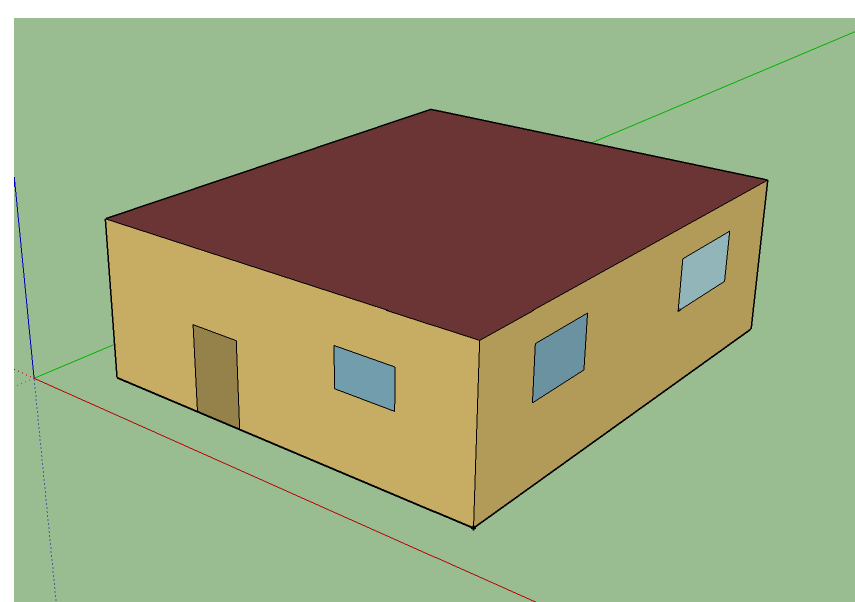
Figure A1. The sketchup model used for varying internal parameters.